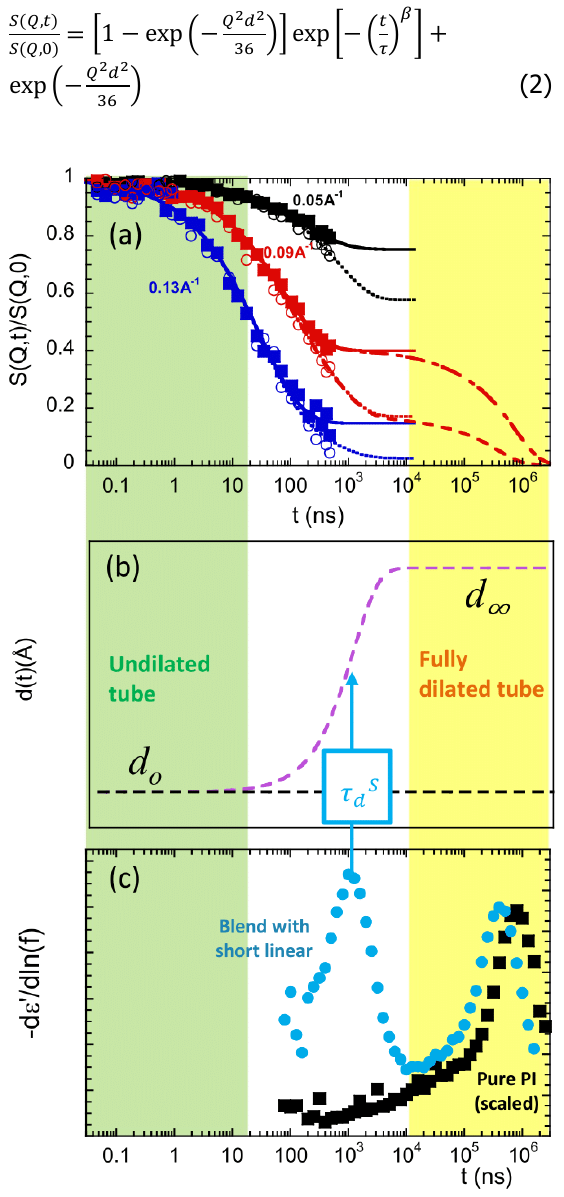
Fig. 1. a) Single-chain dynamic structure factor measured by NSE of long-PI chains in bulk (filled symbols) and in blends with short linear (empty symbols) at 𝝓 𝑳 = 𝟎. 𝟓 and the three values of the scattering vector indicated. Lines are fits as explained in the text. b) Time dependence of the tube diameter. c) Normalized natural-log frequency (f) derivative of the real part of the dielectric permittivity as a function of the time variable t = 1/(2 p f). All results correspond to 423